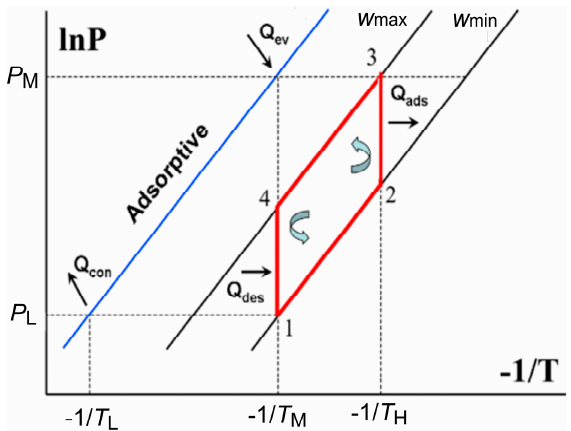
Figure 7. P-T diagram of the isothermal “Heat from Cold” (HeCol) cycle [43].